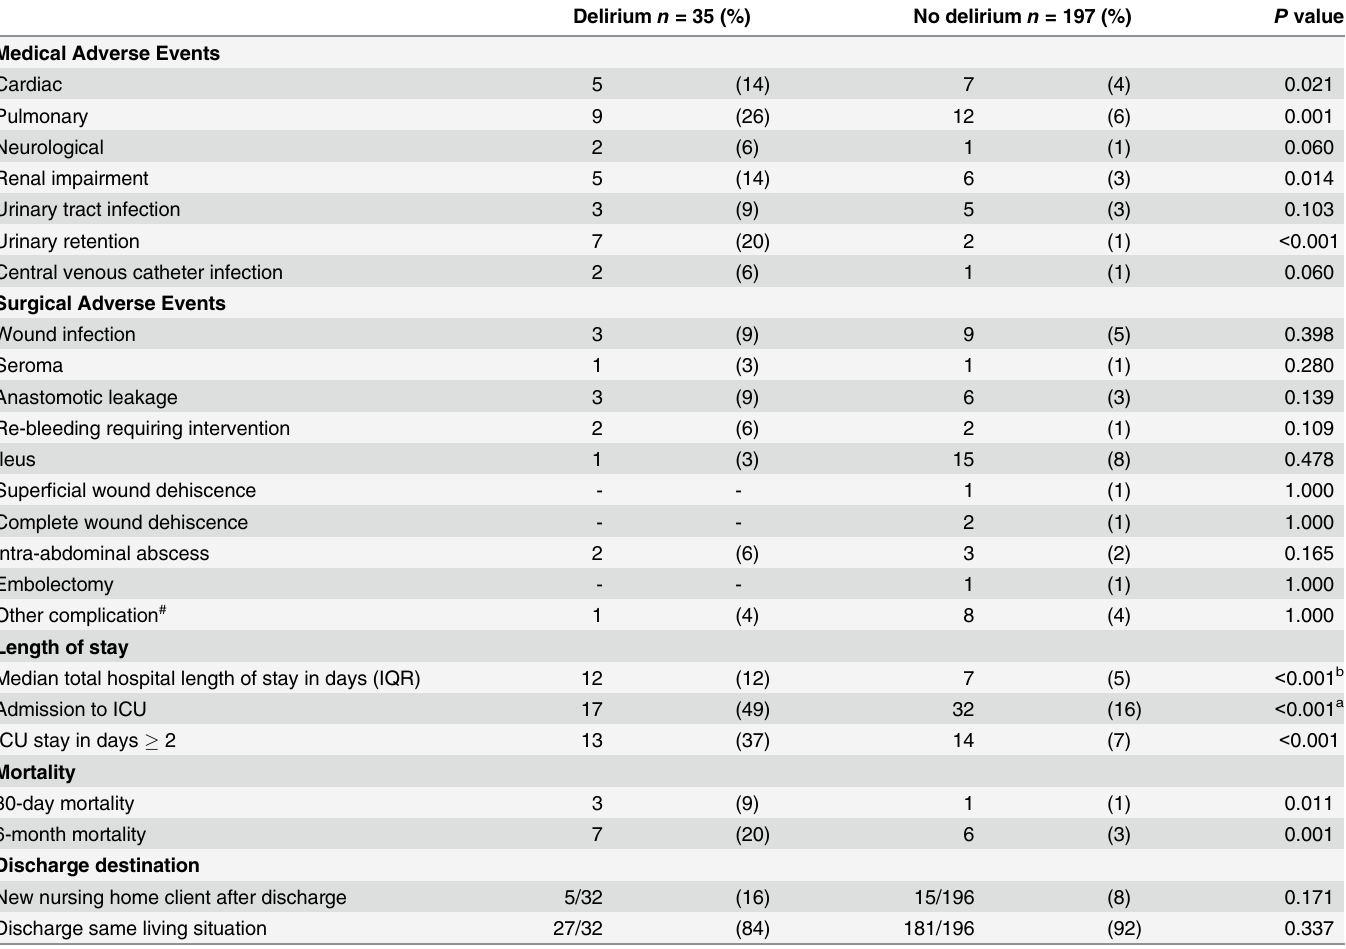
Table 5. Adverse events, Hospital length of stay, ICU stay and mortality in relation to onset of postoperative delirium. Delirium n = 35